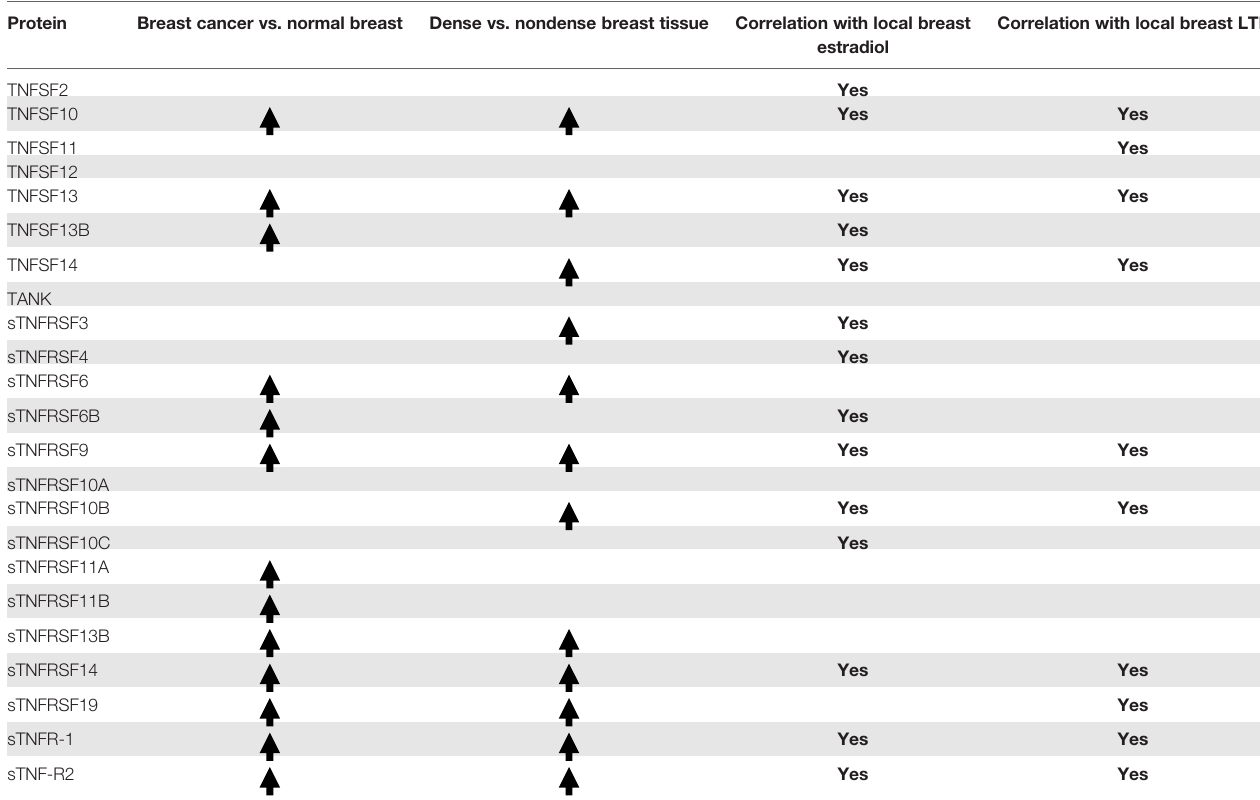
TABLE 1 | Microdialysis was performed in breast tissue in women and proteins and estradiol were quanti fi ed in the dialysates. Protein Breast cancer vs. normal breast Dense vs. nondense breast tissue Correlation with local breast